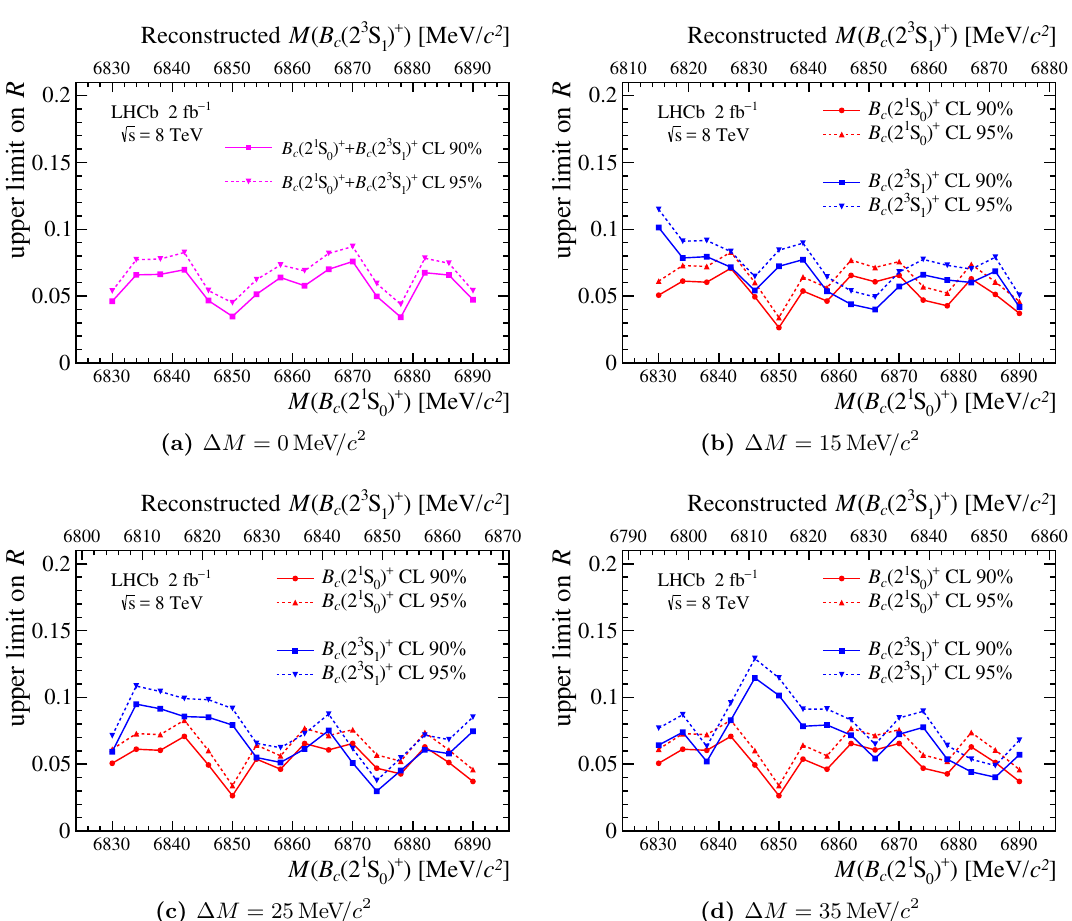
Figure 4. The upper limits on the ratio R ( B ( (cid:3) ) c (2 S ) + ) at 95% and 90% con(cid:12)dence levels under di(cid:11)erent mass splitting (cid:1) M